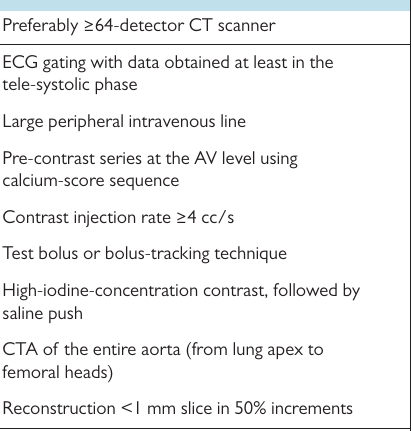
Table 1. Basic scanning parameters